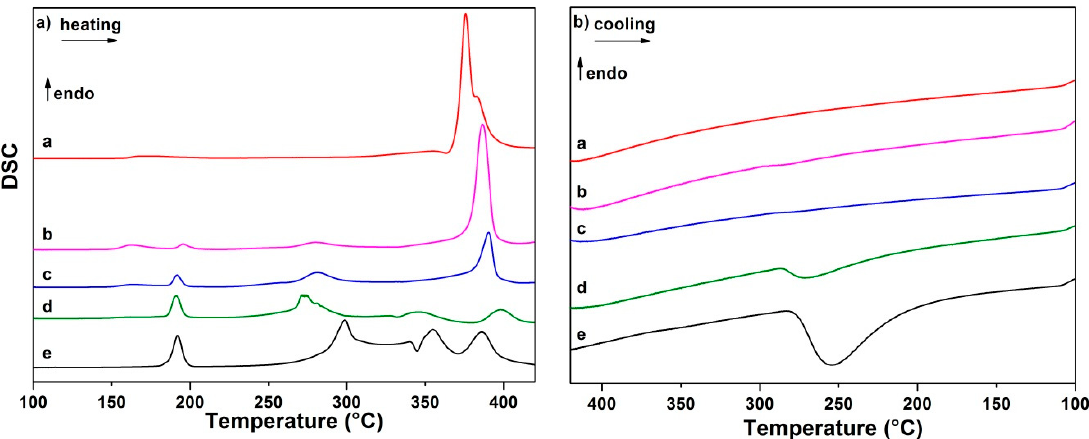
Figure 5. DSC analysis up to 420 °C at 5 °C/min, under 2 bar of H 2 , of (a) Ca(BH 4 ) 2 , (b) 1Mg(BH 4 ) 2 : 2Ca(BH 4 ) 2 , (c) 1Mg(BH 4 ) 2 : 1Ca(BH 4 ) 2 , (d) 2Mg(BH 4 ) 2 : 1Ca(BH 4 ) 2 , and (e) Mg(BH 4 ) 2 . ( a ) heating and ( b ) cooling ramp.